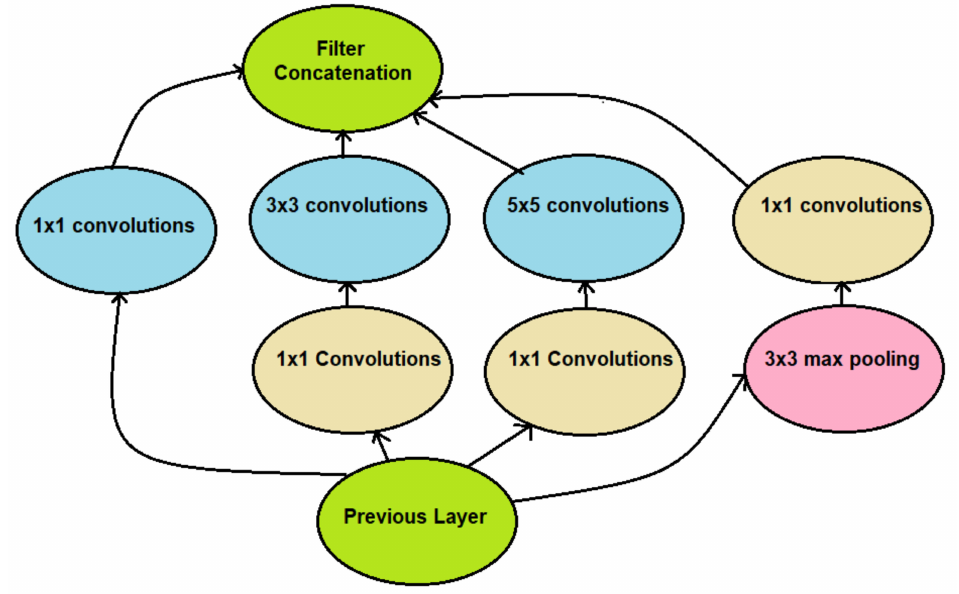
Figure 5. Recreated Inception architecture with dimension reductions, based on original image found in